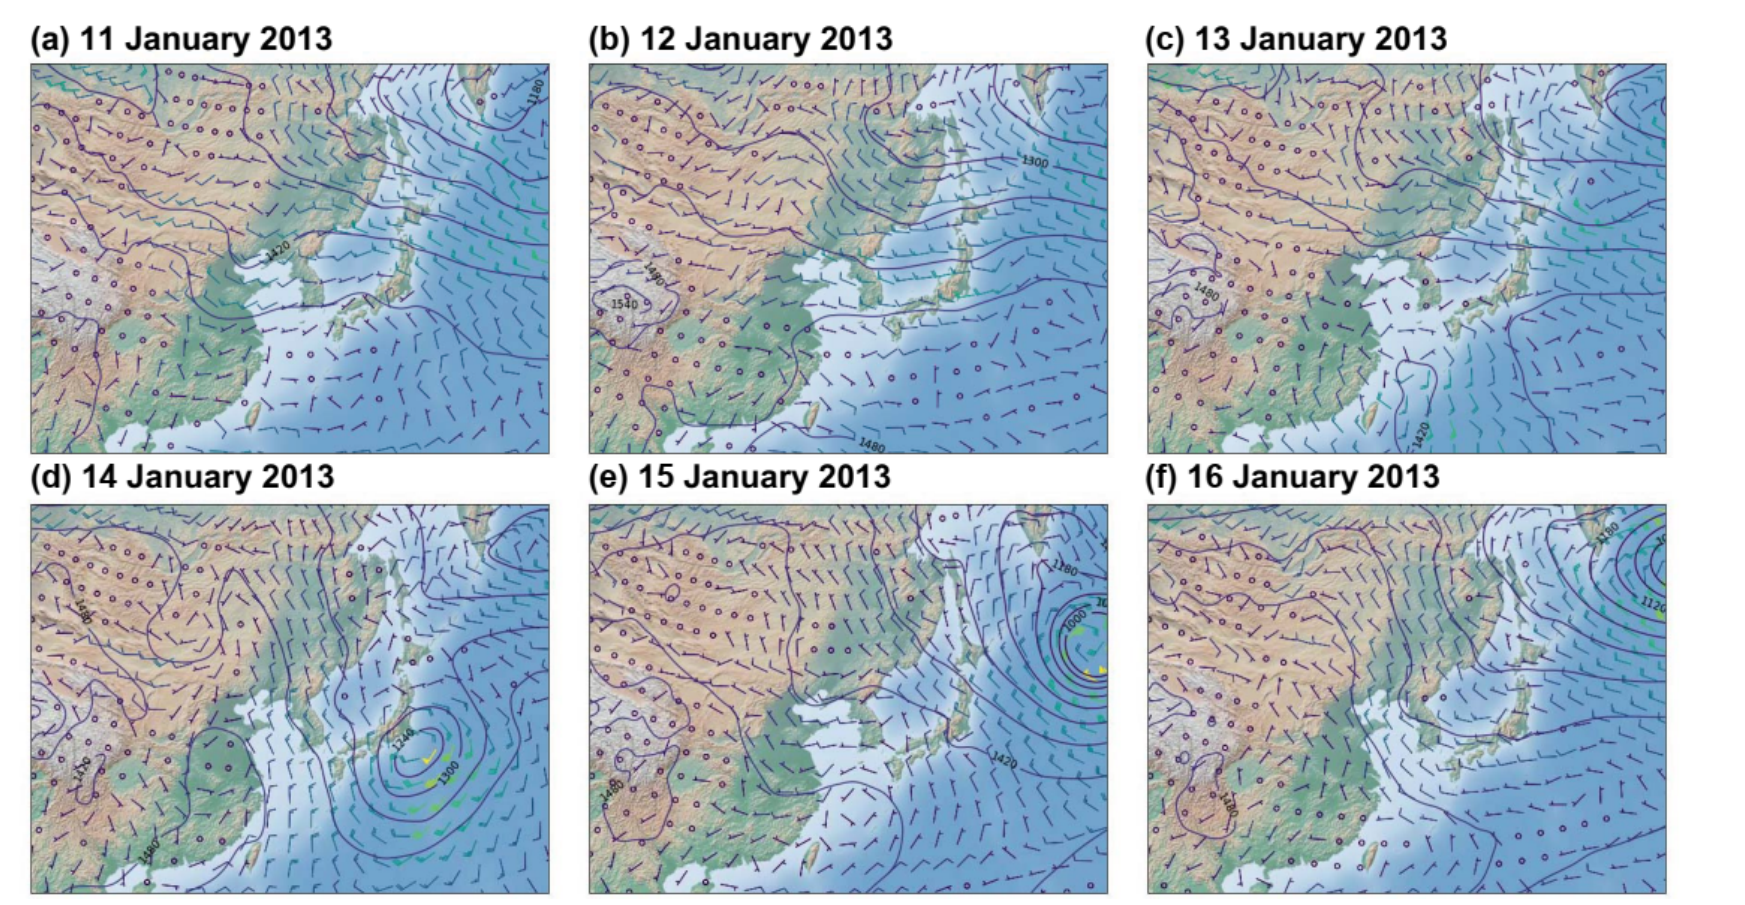
Figure 4. 850 hPa synoptic weather charts at 0600 UTC during 11–16 January 2013. Purple line indicates geopotential height (contoured every 60 m). Wind flags represent wind direction and wind speed (unit: m s − 1 ).